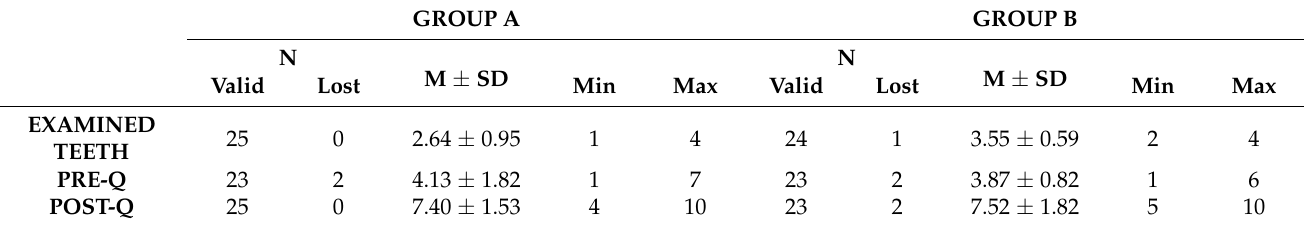
Table 3. Descriptive statistics of the study (M, mean; SD, standard deviation).